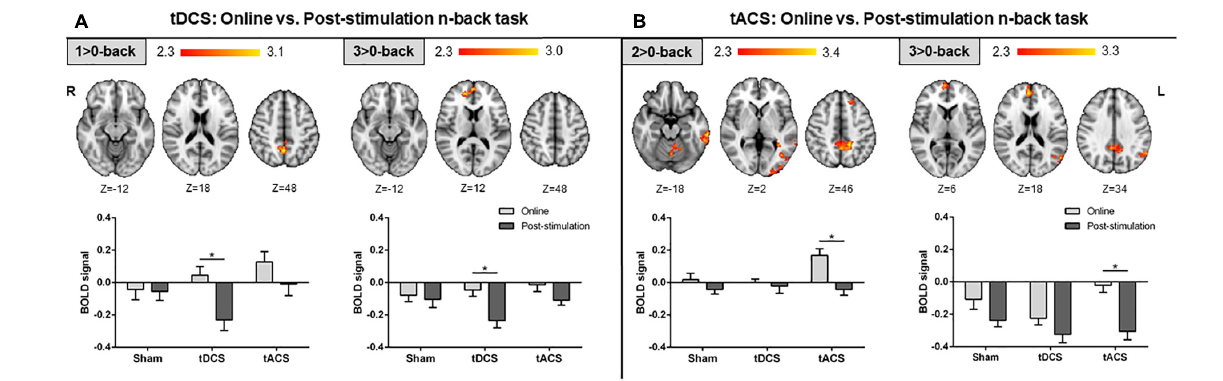
FIGURE 4 | Comparison between the online and post-stimulation fMRI n-back tasks in each group. (A) Online vs. post-stimulation results in the tDCS group. (B) Online vs. post-stimulation results in the tACS group. Top: statistically significant fMRI activity maps on the standard MNI for each contrast of interest. Results are shown in red-yellow for higher activations (or lower deactivations) online as compared to post-stimulation. Down: plots of mean BOLD signal values at the fMRI clusters considering sham, tDCS and tACS where significant differences between both fMRI n-back tasks were found. Data are presented as mean with standard error of the mean ( SEM ). tDCS, transcranial direct current stimulation; tACS, transcranial alternating current stimulation; BOLD, blood oxygen level